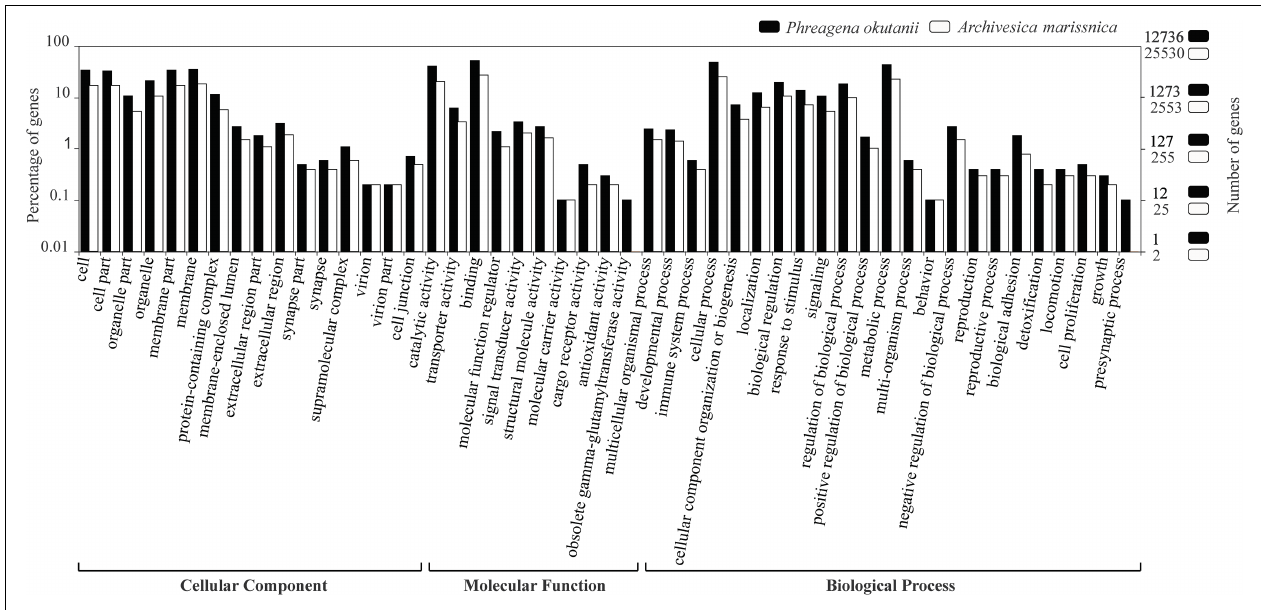
FIGURE 1 | Gene ontology distribution of BLASTp hits from the predicted protein sequences of Phreagena okutanii (solid) and Archivesica marissinica (open). The left and right y -axis show the percentage and number of genes classified into different gene ontology items,